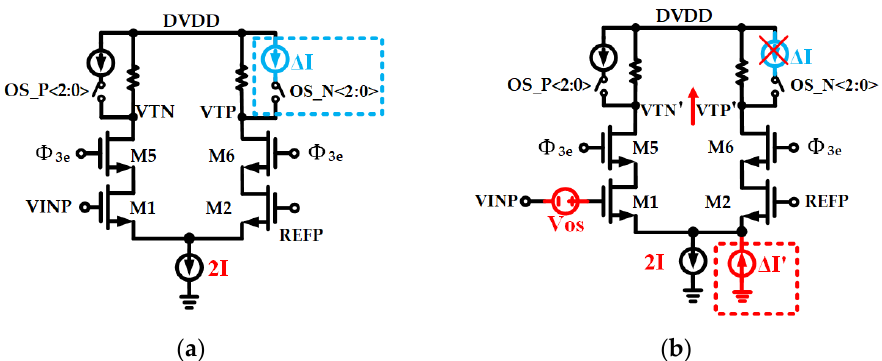
Figure 6. Comparator schematic, including pre-amplifier, strong-arm latch, and buffer. φ 4 and φ 4e are clocks for the designed comparators.